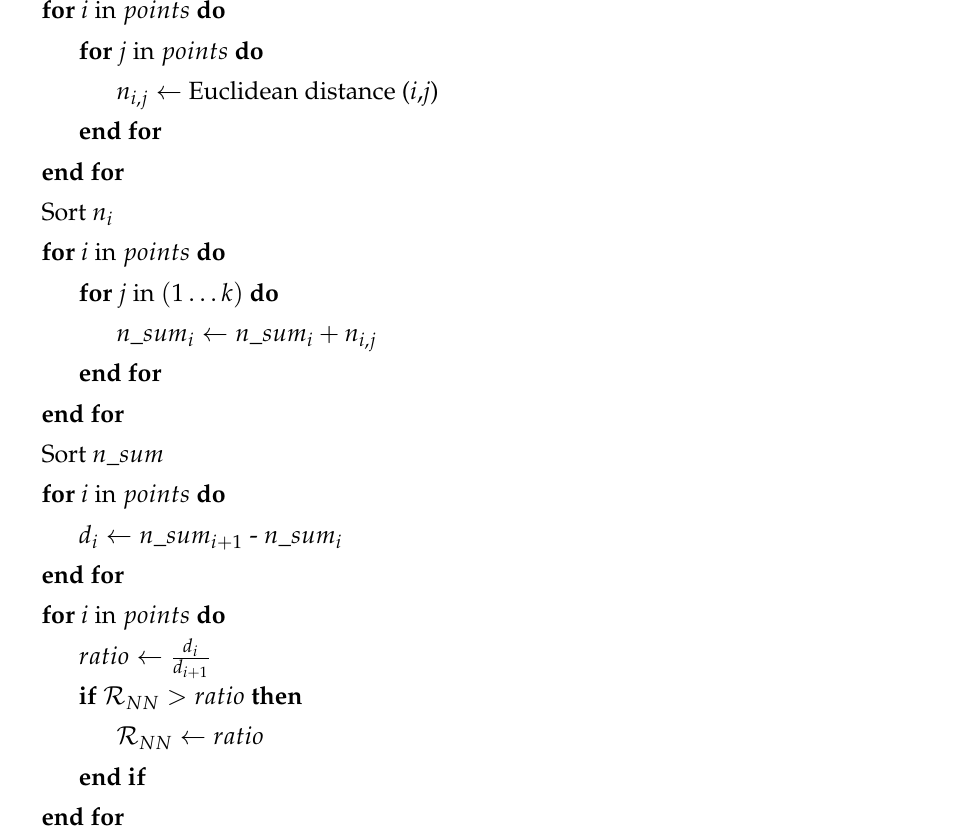
Algorithm 1 Algorithm for the neighbor-based minimization